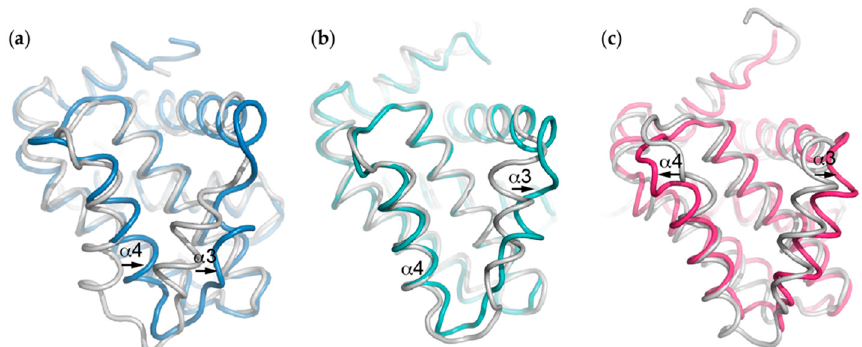
Figure 3. Movement of the α 3 and α 4 helices that form the “walls” defining the canonical ligand-binding groove to accommodate BH3 ligand binding di ff ers between the di ff erent pro-survival proteins. Comparison of the structures of the apo pro-survival proteins (white) with just the pro-survival target from the BH3-bound form (i.e., with ligand removed) ( a ) Bak BH3:Bcl-x L (PDB ID: 1BXL, blue), ( b ) Bax BH3:Bcl-2 (PDB ID: 2XA0, aqua) and ( c ) Bim BH3:Mcl-1 (PDB ID: 2NL9, pink) complexes exemplify this.